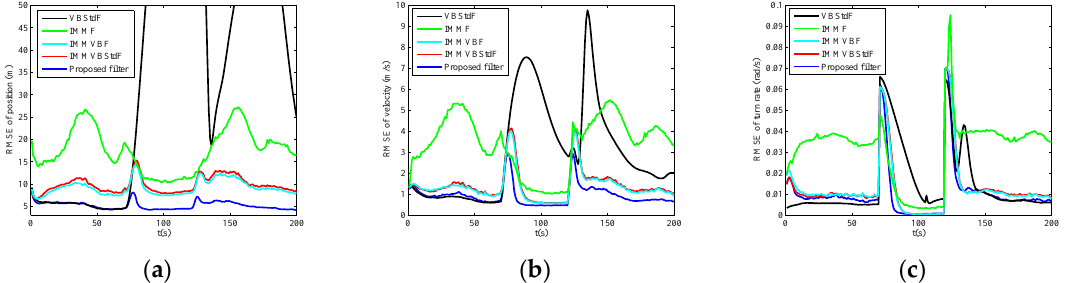
Figure 3. RMSEs versus time in Case B. ( a ) Position; ( b ) Velocity; ( c ) Turn rate.